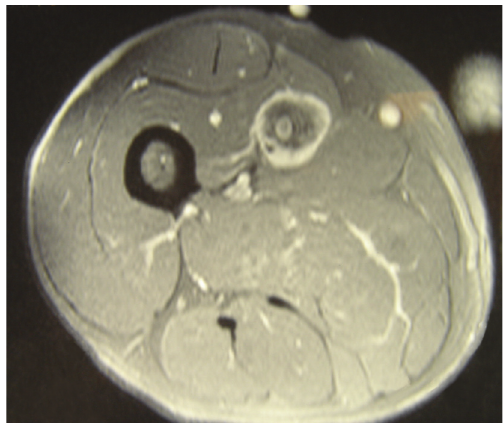
Figure 1: MRI picture of Leiomyosarcoma arising from the femoral vein.